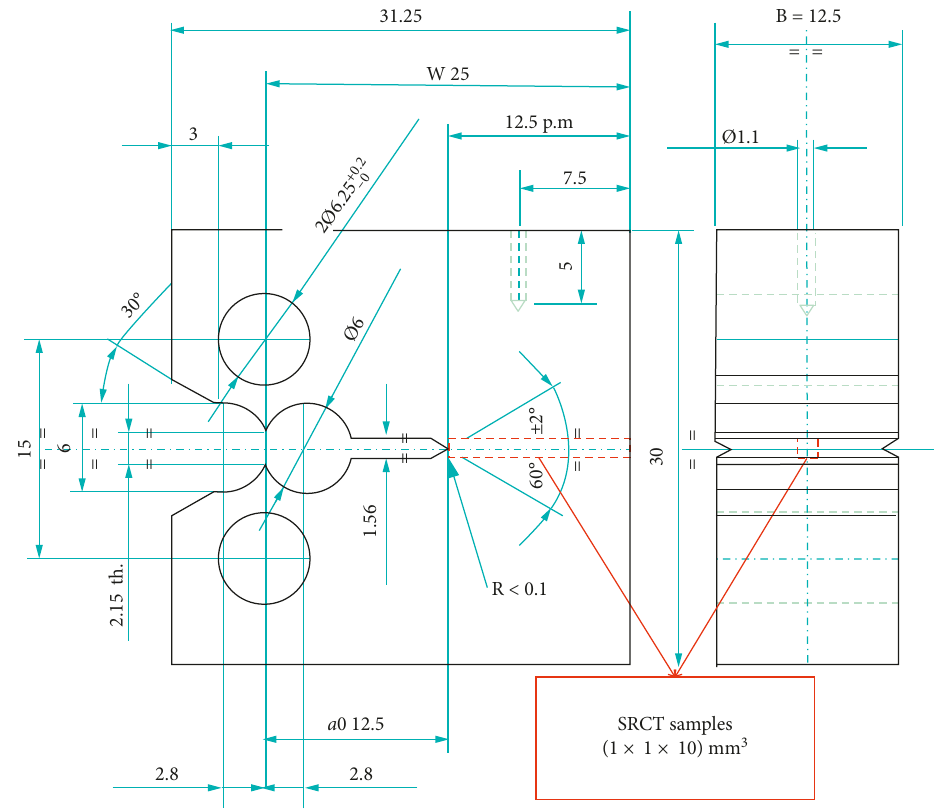
Figure 1: Geometry of CT specimens and position of SRCT samples (red